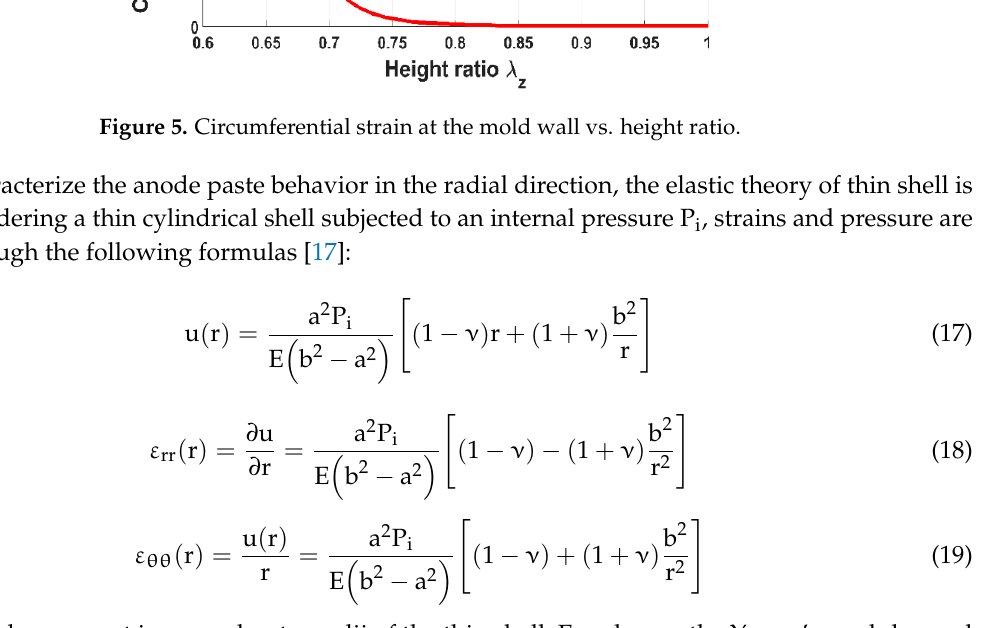
Figure 5. Circumferential strain at the mold wall vs. height ratio.